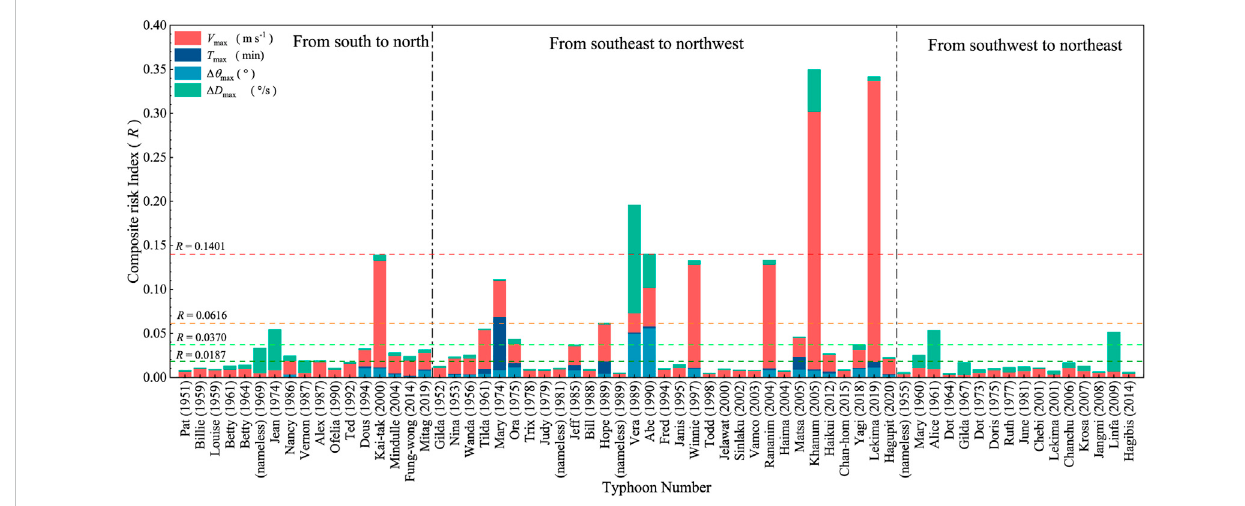
FIGURE 11 Distribution of historical tropical cyclone composite risk index for the Donghaitang wind farm area. Red, dark blue, blue, and green bars represent theproportionof V max , T max , Δ θ max ,and Δ D max inthecompositeriskindexfortropicalcyclones.Darkgreen,green,orangeandredhorizontaldashedlines are the threshold cutoffs when R equals 0.0187, 0.0370, 0.0616, and 0.1401, respectively, and the vertical black dot-dashed lines are thetropical cyclone track cutoffs: (left to right) south to north, southeast to northwest, and southwest to